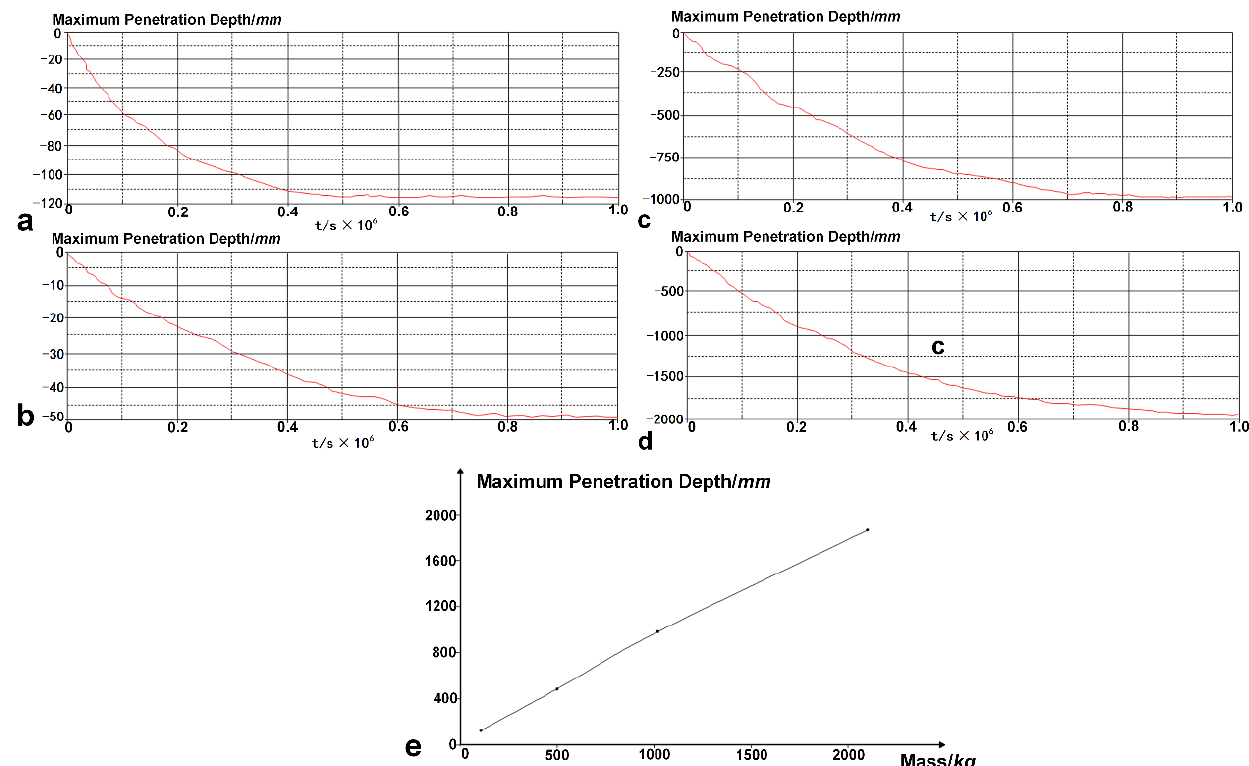
Figure 7. The maximum penetration depths of different anchor weights. ( a ) Case F1-1; ( b ) Case F1-2; ( c ) Case F1-3; ( d ) Case F1-4. ( e ) The relationship between the maximum penetration depth and the anchor weight.